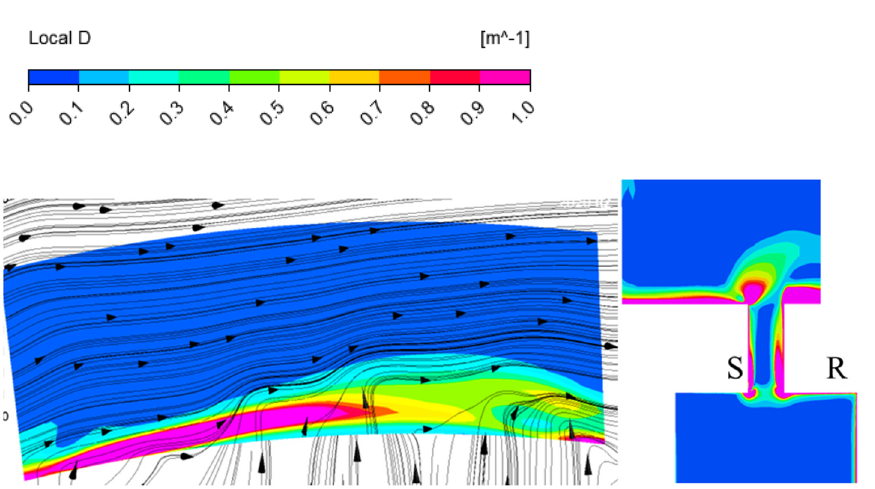
Figure 13. The dissipation coefficient distribution at the exit of disk cavity, IR = 1.5%. (Left: axial direction, right: circumferential direction).